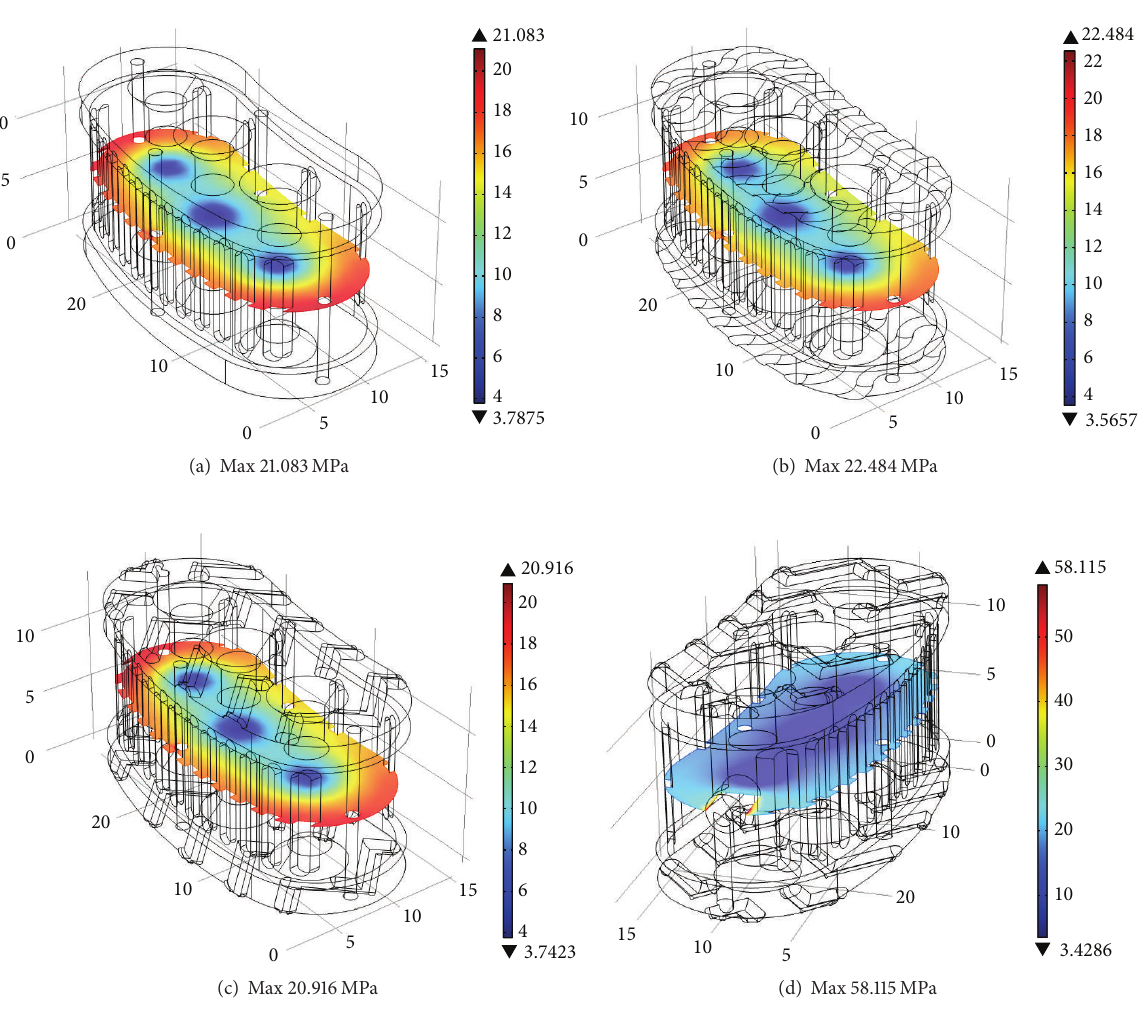
Figure 8: Cross section analysis for middle plane: von Mises stress distribution with 4,000 N as reference